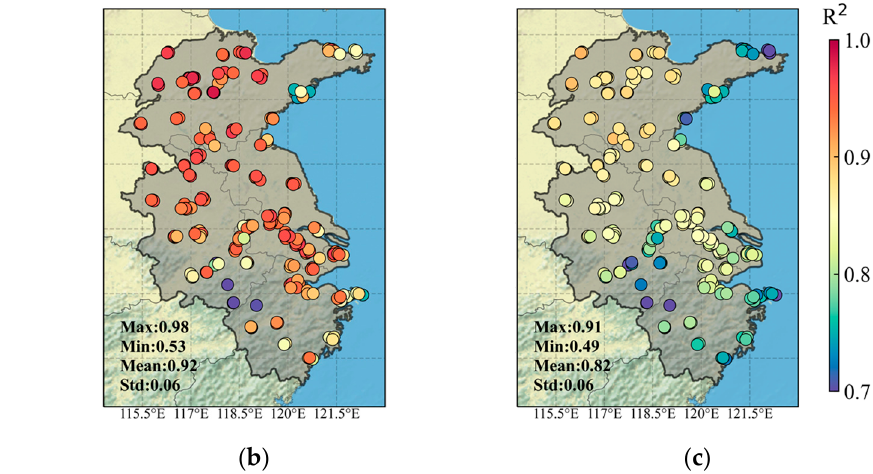
Figure 5. R 2 value of sites in ( a ) sample-based CV, ( b ) space-based CV, and ( c ) time-based CV.